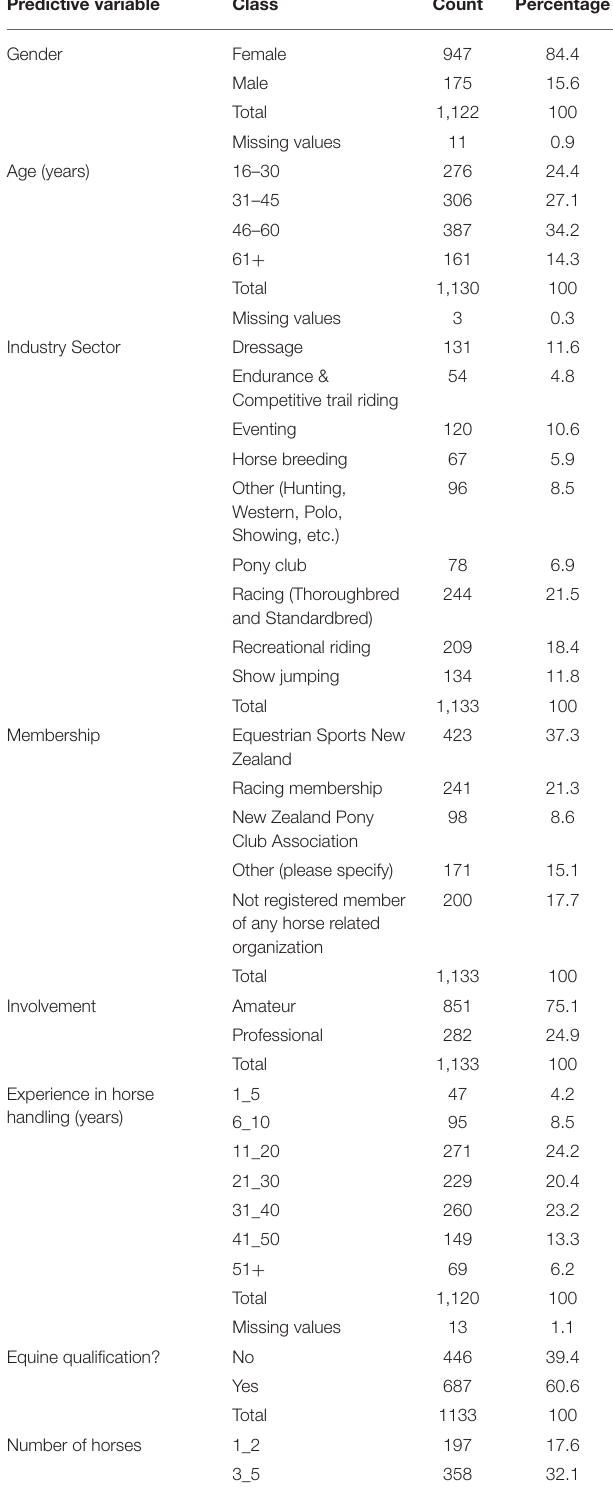
TABLE 2 | Frequency table for demographics characteristics and equine industry involvement of respondents to a survey on horse transportation practices in New